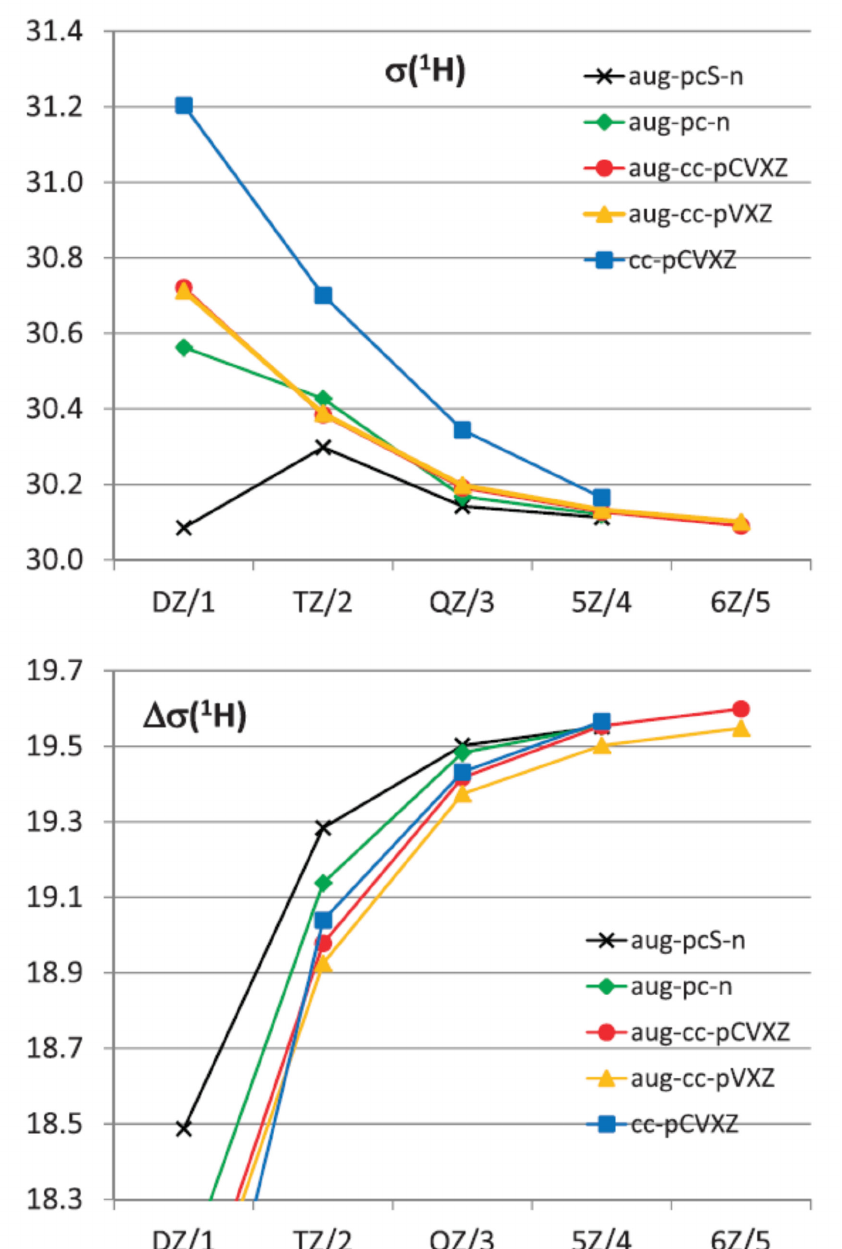
Figure 10. The ZPVC-averaged isotropic shielding ( top ) and shielding anisotropy ( bottom ) of hydrogen in the 1 H-NMR spectrum (ppm) of water calculated at the CCSD(T) level as a function of the cardinal number X (or n) in the cc-pCVXZ, aug-cc-pVXZ, aug-cc-pCVXZ, aug-pc-n, and aug-pcS-n basis sets. Reproduced from Faber et al. [104] with the permission of Taylor &